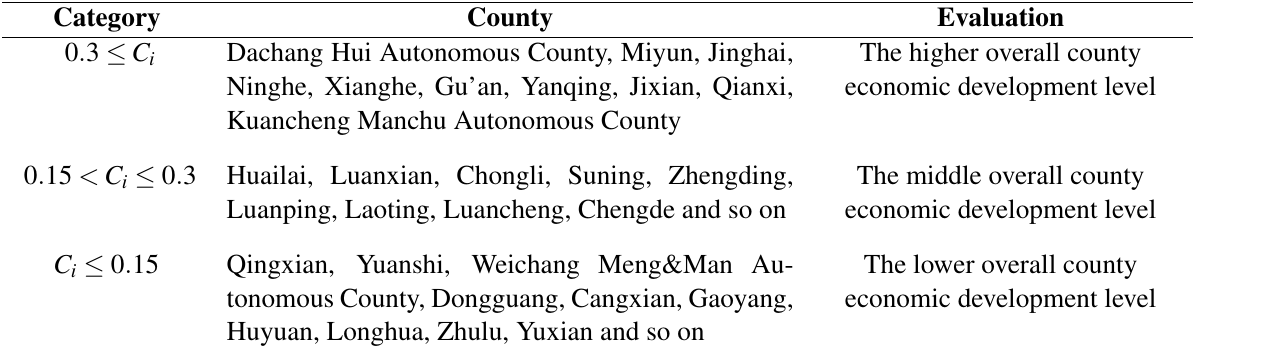
Table 4 An analysis of overall differences in the Bejing-Tianjin-Hebei region.